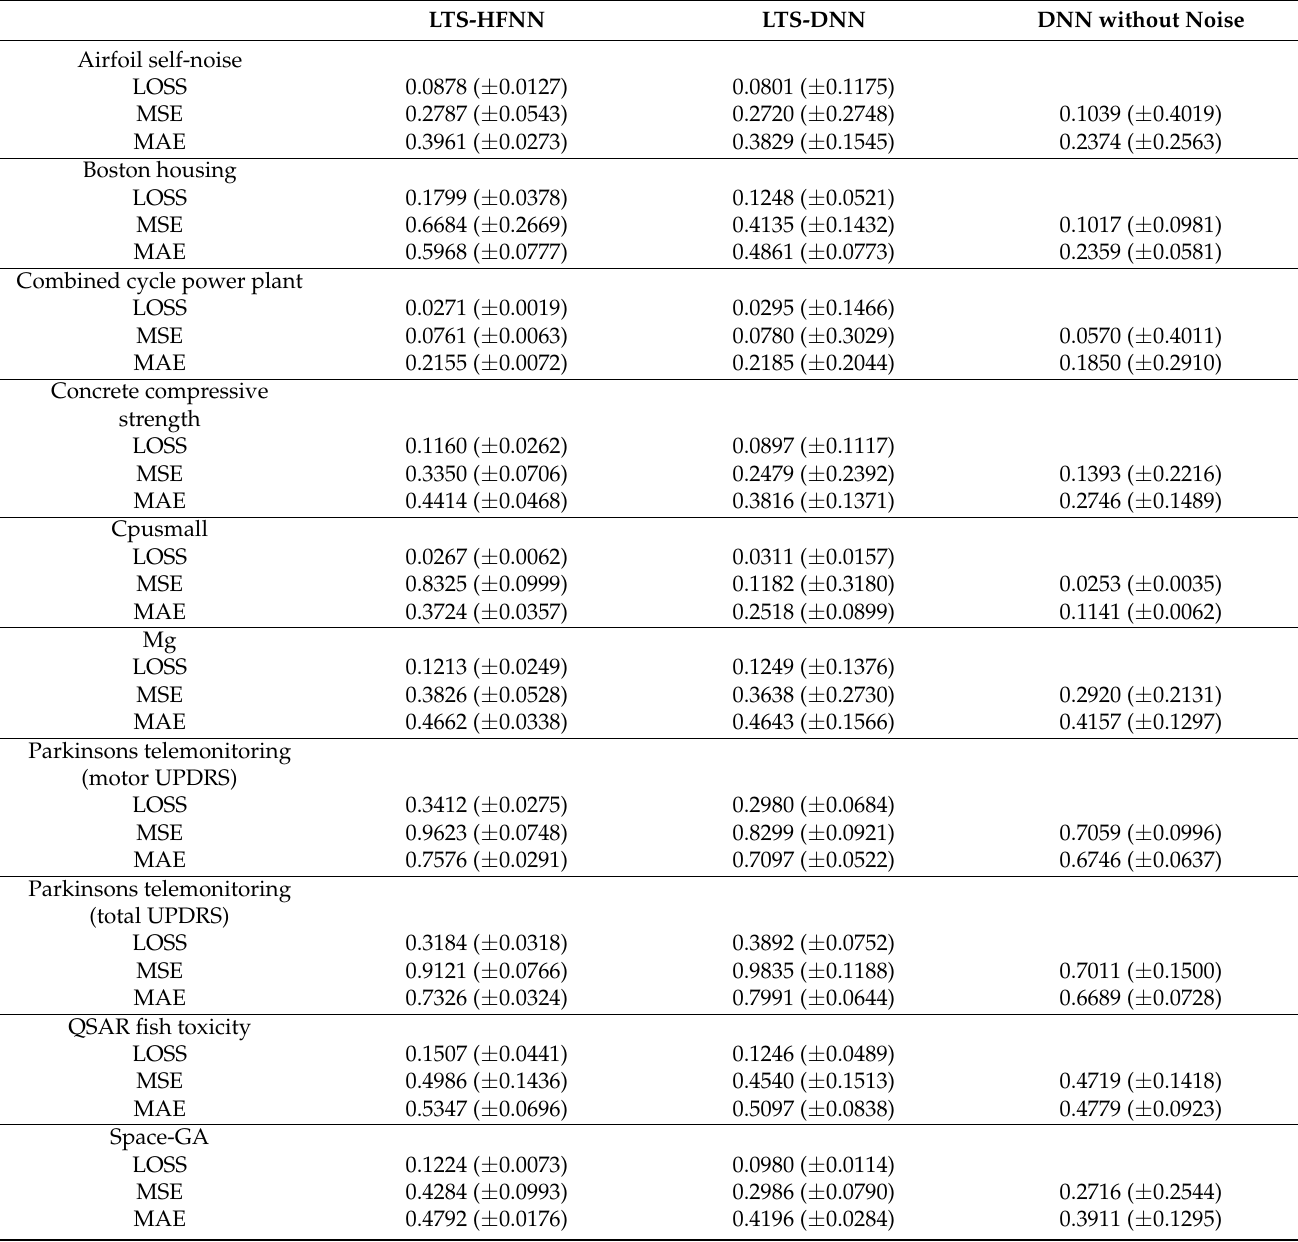
Table 5. Simulation results in Example